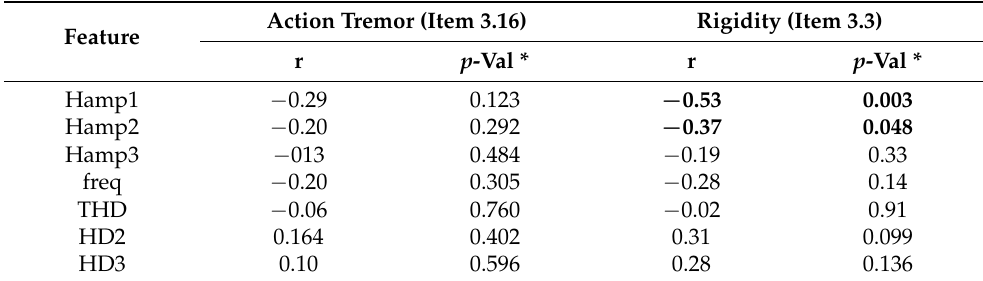
Table 7. Spearman’s rank correlation coefficients in patients with Parkinson’s disease when in off state of